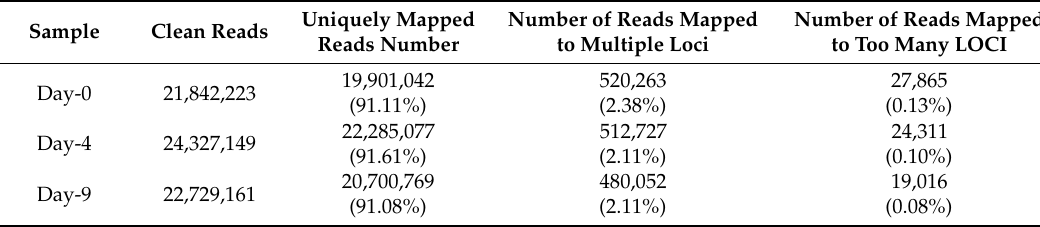
Table 2. Statistics and mapping results of RNA-Seq data.